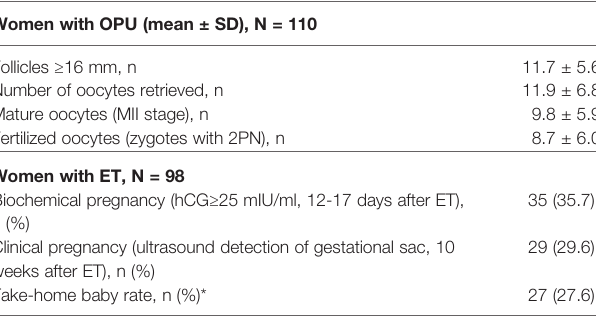
TABLE 2 | Outcomes of ART in a single fresh GnRH-ant protocol. Women with OPU (mean ± SD), N =